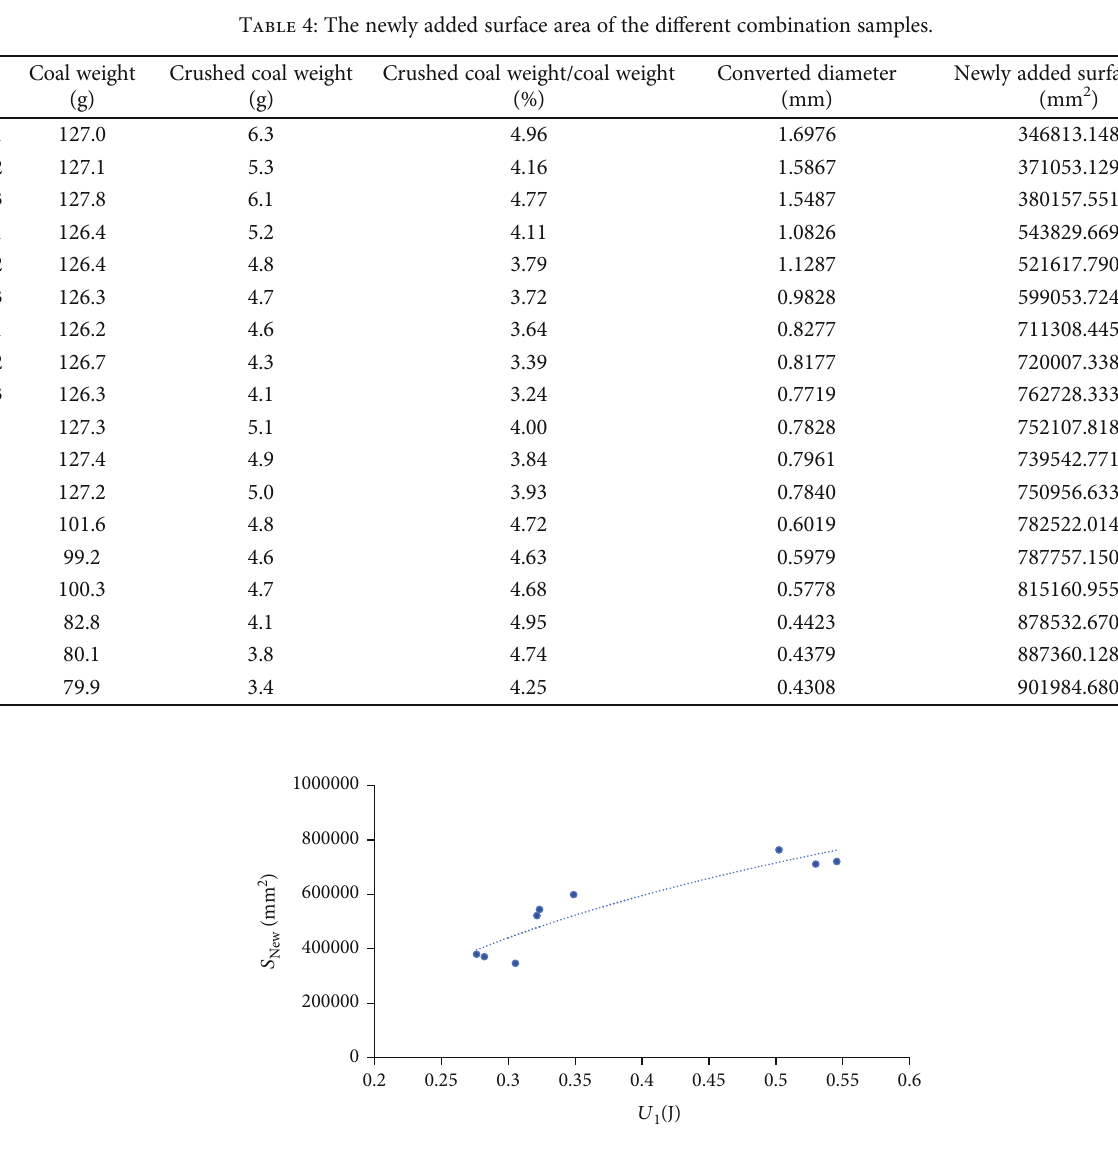
Figure 13: The relationship between S